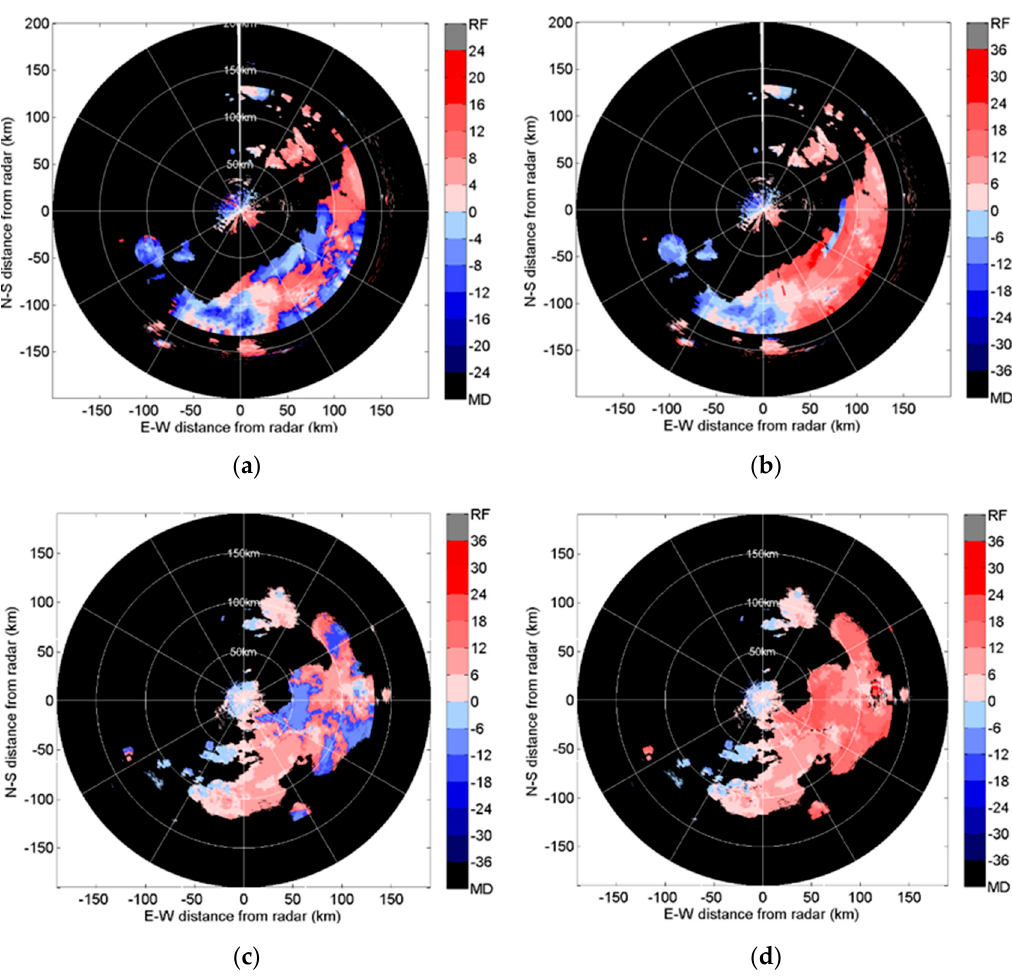
Figure 5. Radar radial velocity from C-band radar stations in the CINRAD network: ( a ) raw velocity of the 3.3° elevation angle at 07:05 (UTC), 23 July 2009 from the Zhangbei radar; ( b ) dealiasing result of Figure a; ( c ) raw velocity of the 4.3° elevation angle at 08:06 (UTC), 27 June 2008 from the Datong radar; and ( d ) dealiasing result of Figure c. The spatial scales of the pairs of images at different elevations are different.